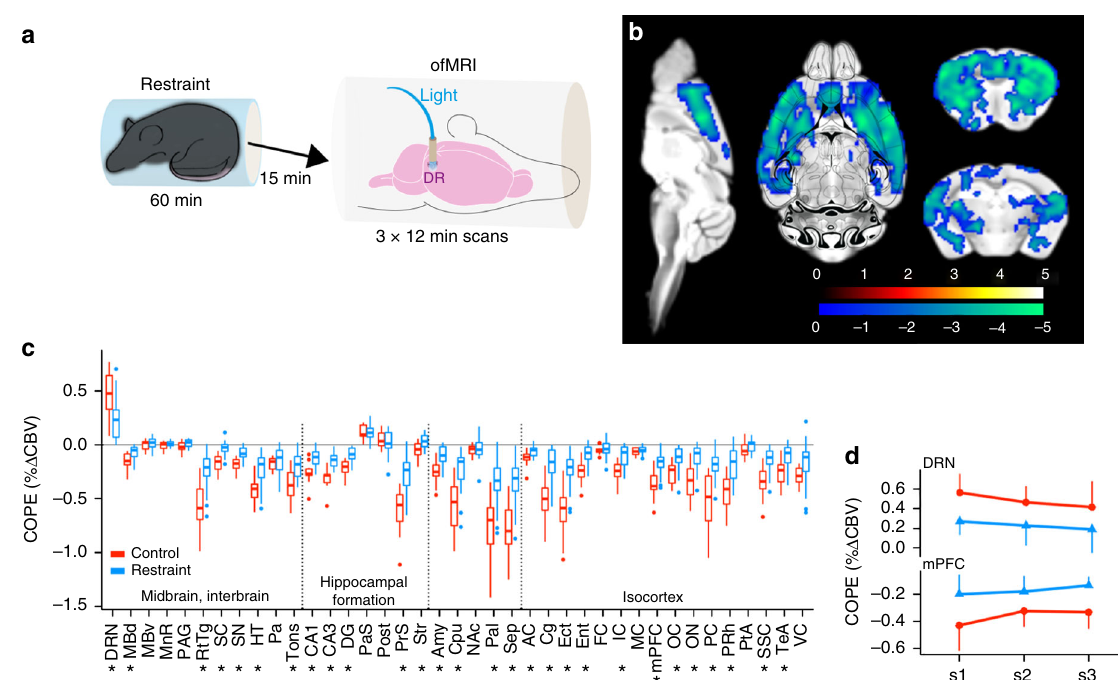
Fig. 4 Acute stress occludes photoactivation of the DRN 5-HT circuit. a Experiment schematic. b Second level analysis comparing restraint ( n = 7) to control ( n = 4) condition indicate a decrease in negative response amplitude in the restraint group relative to control across the brain. Colour scale = t - statistic (non-parametric test, p ≤ 0.05, cluster corrected), blue indicating signi fi cance for restraint > control comparison; see Supplementary Figure 13 for all brain slices. c COPEs comparing restraint (blue) and control (red) indicate reduced response amplitudes in the majority of responding ROIs, including DRN (* p < 0.05, FDR corrected). Bound of box and centre line represent 25th, 50th, 75th percentiles, whiskers represent 1.5*inter-quartile range. d The blunted response to photoactivation following acute stress persists across the three consecutive scans of each session. Error bars indicate ±1